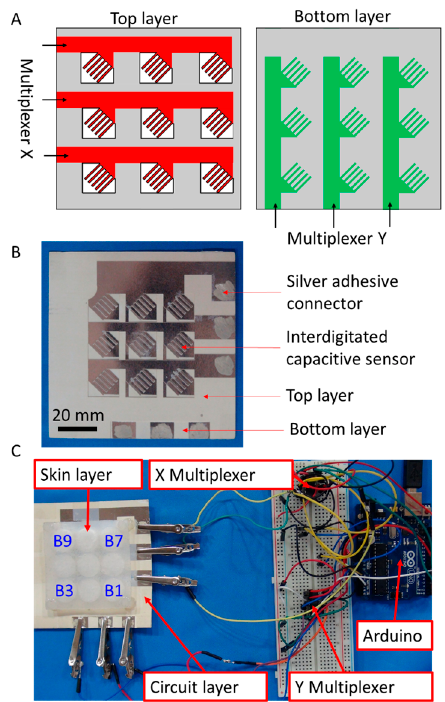
Figure 3. A diagram and photograph of a three-by-three arrayed sensor for measuring force. ( A ) Diagram of two multiplexers and stacked sheets of patterned metallized paper. The top and bottom layers connect with a multiplexer to reduce the number of required wires and demonstrate the scalability of the electromechanical sensors. The white areas in the top layer are the removed regions. The grey areas in both layers are the partially-ablated regions; ( B ) Photograph of the circuit; ( C ) Photograph of the measurement system.